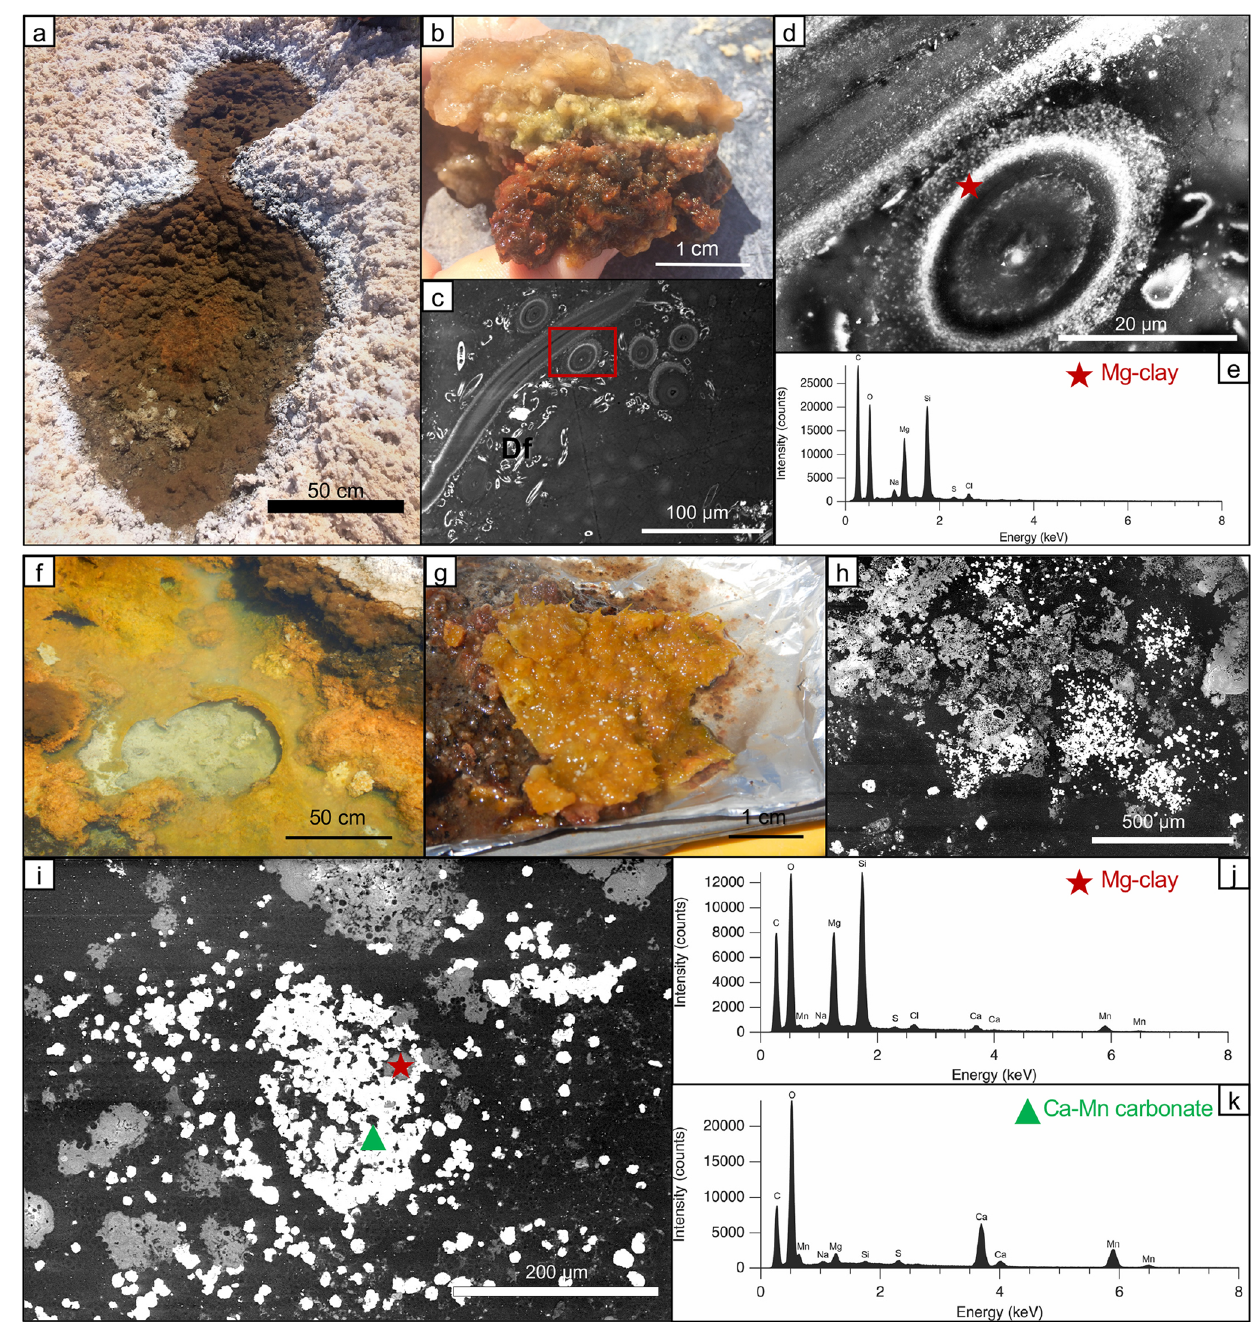
Fig. 3 SEM and EDS of samples. a – e Orange/brown bulbous mat (sample P163): a Depositional setting in pond, b hand sample ( from 12 Fig. 6a), c SEM image of fi lamentous cyanobacteria surrounded by Mg-clay, d higher resolution SEM image from red box in ( c ) showing Mg-clay precipitation around the cell-sheath; diatom frustules ‘ Df ’ are abundant ( e ) EDS spectrum from spot indicated by red asterisk in ( d ). Orange gel mat (P31): f Depositional setting in pond, g hand sample, h , i Mg-clay (gray) throughout an EPS alveolar network together with intermixed accumulations of Ca – Mn carbonate (white), j , k EDS spectra from spots indicated in ( i ). See Supplemental Table S3 for all eZAF smart quant